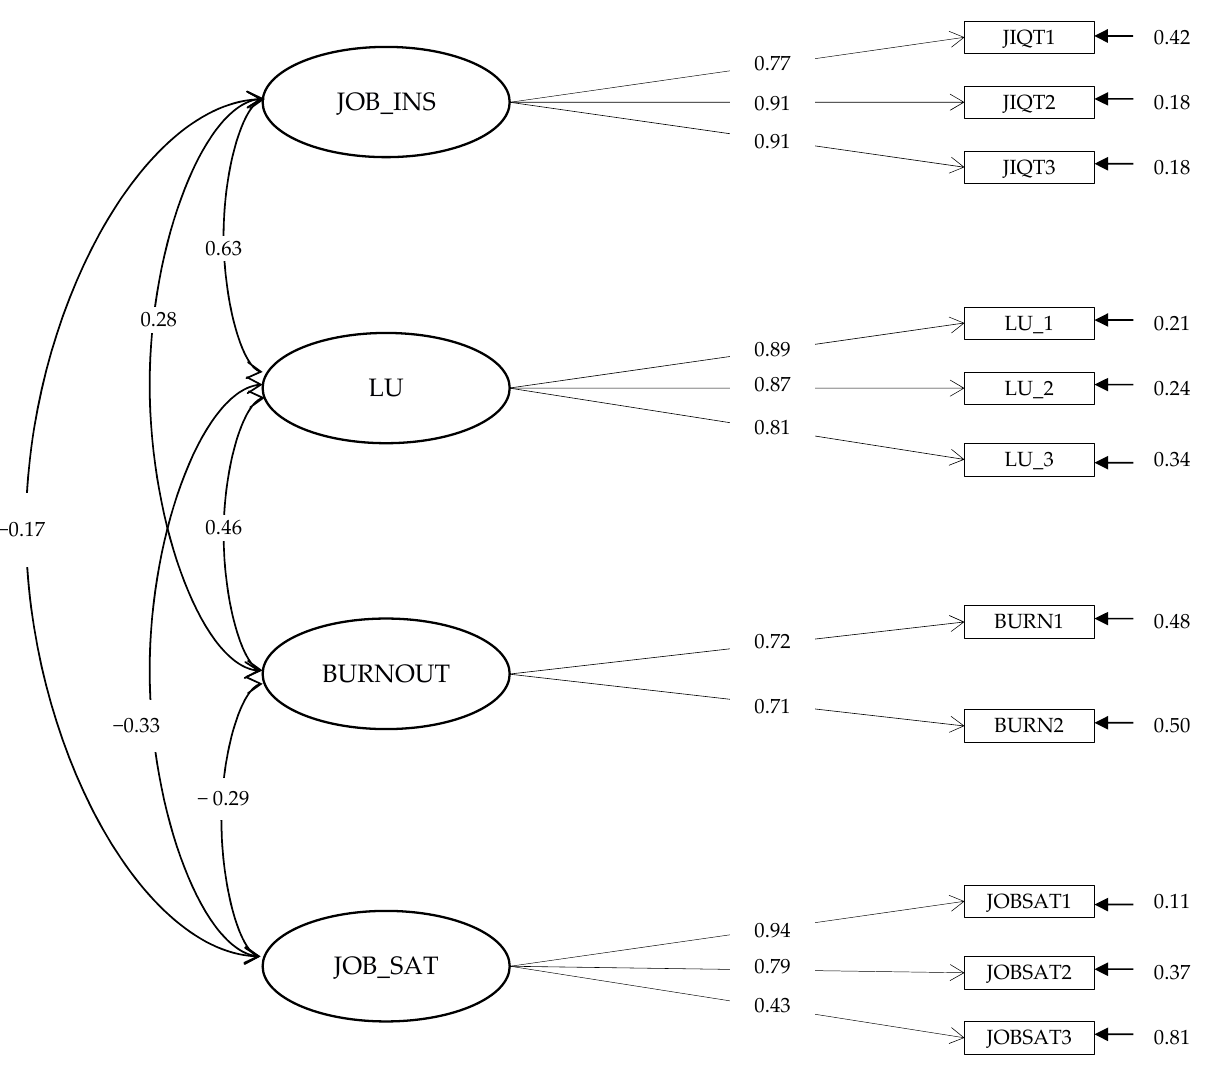
Figure 2. The Measurement Model. JOB_INS, job insecurity; LU, life uncertainty; JOB_SAT, job satisfaction.